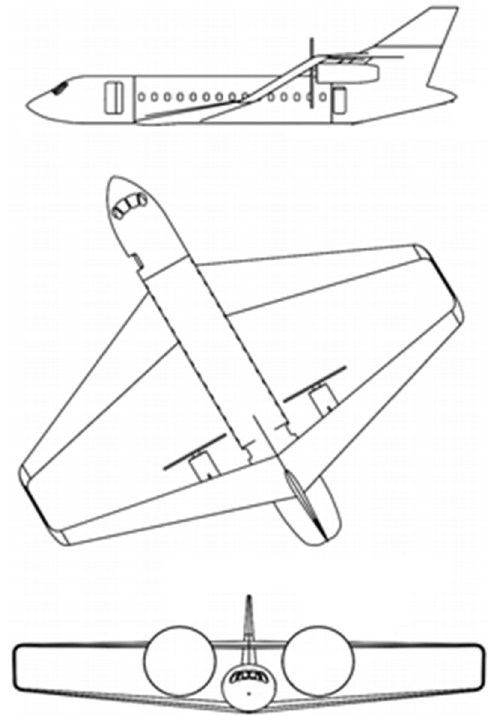
Fig. 14. Example of the tryptic of a con fi guration obtained by